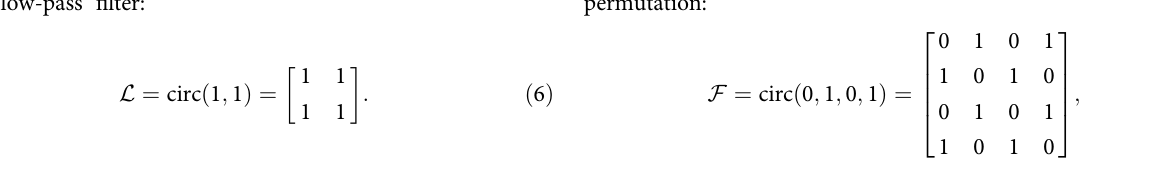
The third type of circulant matrix represents a 4-cycle